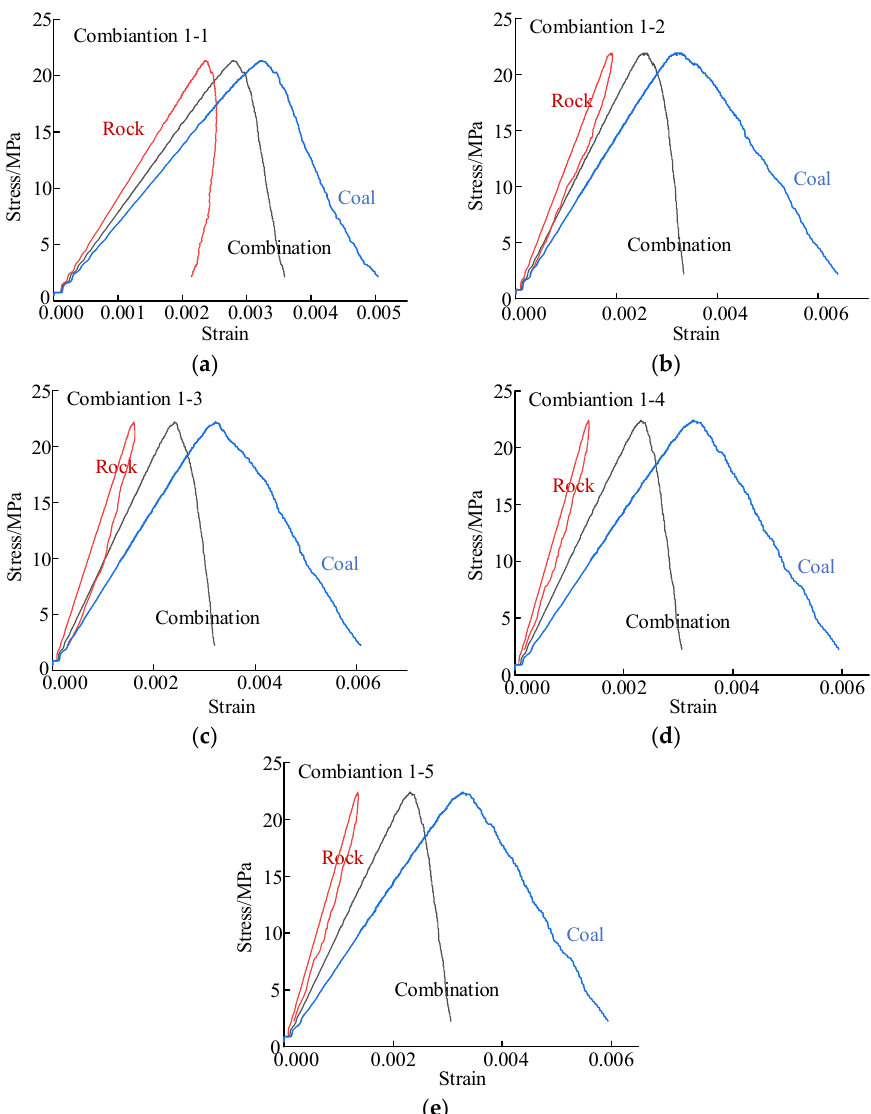
Figure 4. Partition stress–strain curves of coal–rock combinations. ( a ) Combination 1-1. ( b ) Combination 1-2. ( c ) Combination 1-3. ( d ) Combination 1-4. ( e ) Combination 1-5.